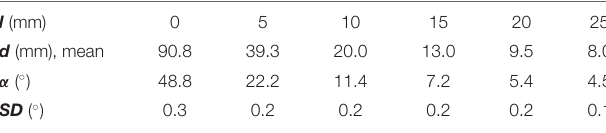
TABLE 1 | Relationship between fiber-tube-distance and angle α for fibers and tubes as used in prototype